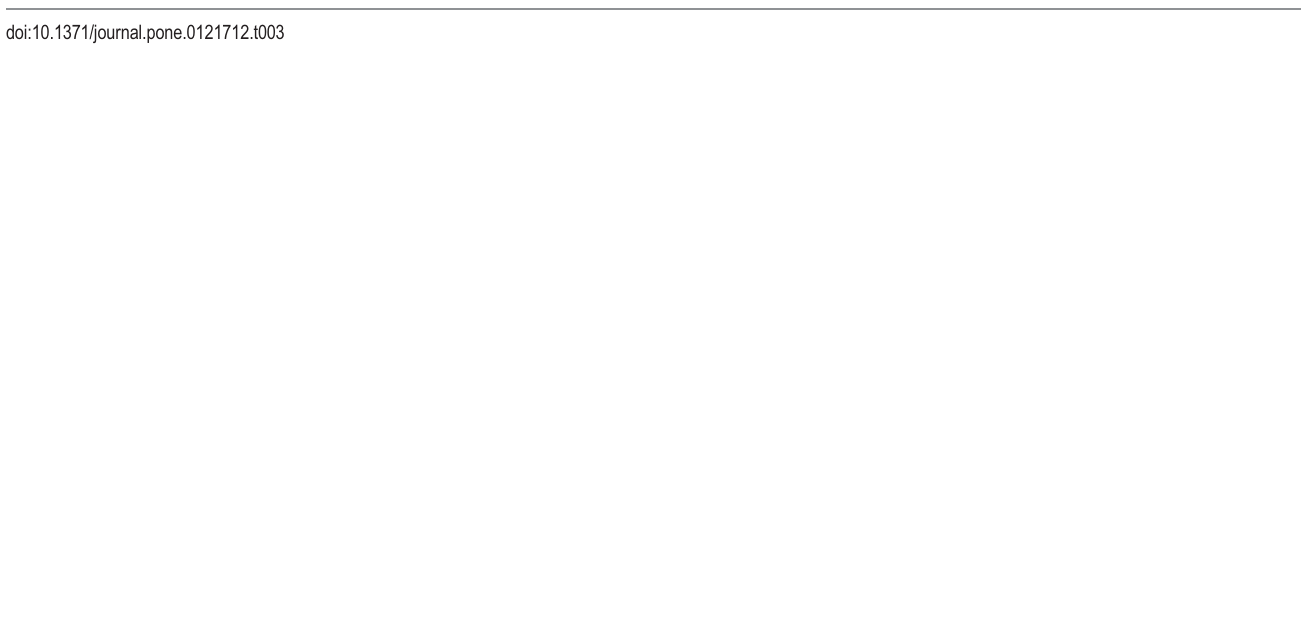
Fig 9. Little finger moment arm values (mm). Left MCP curves, PIP and DIP curves represent flex/extension moment arms as a function of flexion (+)/ extension (-). Right MCP curves represent ab/adduction moment arms as a function of abduction (+)/ adduction (-). Solid curves (with plot markers) represent experimentally derived moment arms from anatomical attachment locations, and dotted curves represent optimally estimated moment arms from data- driven optimizations.